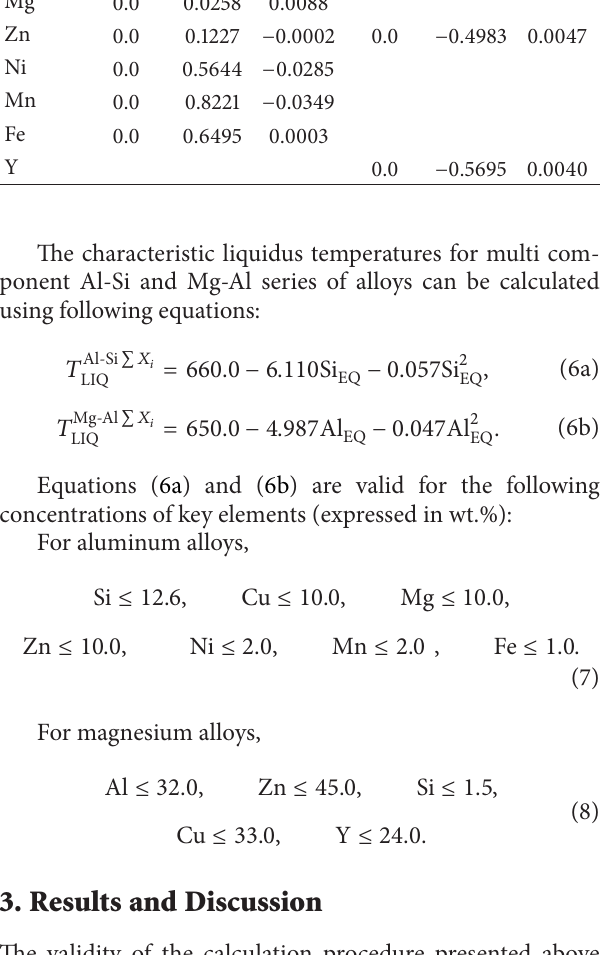
and Al 𝑋 𝑖 function ((4a) EQ EQ